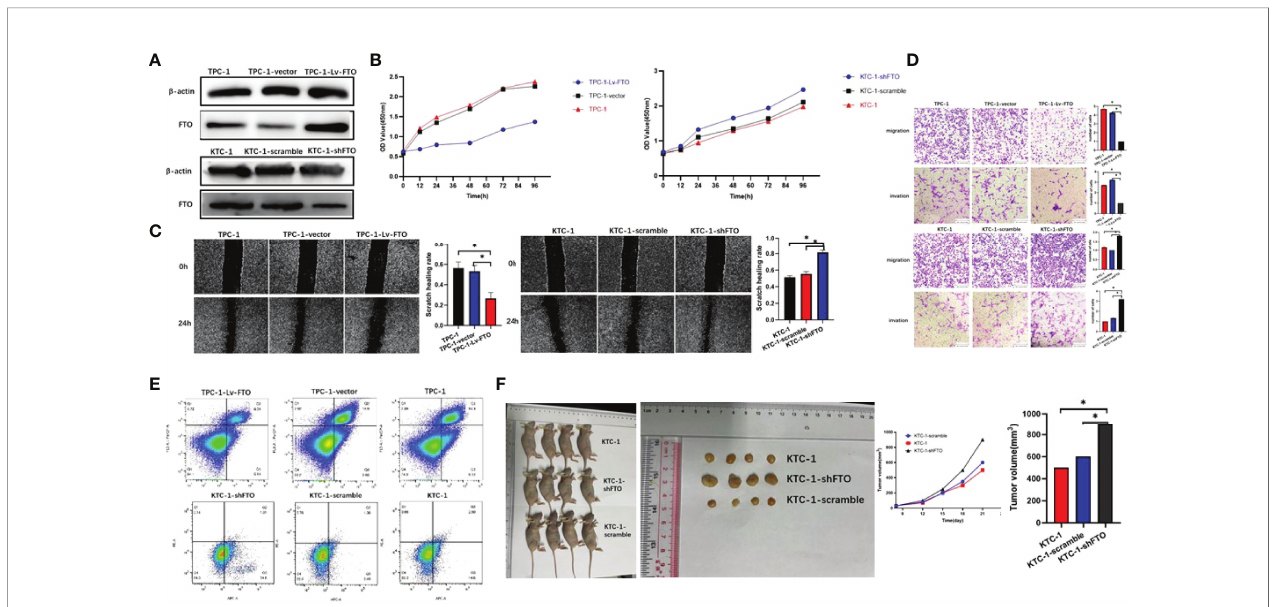
FIGURE 2 | Fat mass and obesity-associated protein (FTO) inhibits papillary thyroid carcinoma (PTC) proliferation, migration, and invasion in vitro and in vivo . (A) Construction of the FTO overexpression model of TPC-1 and the FTO silencing model of KTC-1 as veri fi ed by western blot. (B) Cell proliferation was applied to evaluate the proliferation abilities of three PTC cell lines with knockdown or overexpression of FTO. (C) Wound healing assays showed the suppressed migration of PTC cells, with knockdown or overexpression of FTO, respectively, following FTO overexpression. In contrast, FTO knockdown promoted the migration (wound closure) of PC cells. (D) Transwell migration and invasion experiment. (E) Overexpression of FTO signi fi cantly increased cell apoptosis in PTC cells by fl uorescence- activated cell sorting. (F) Macroscopic image of the tumor size in a xenograft mouse model in which the mice were injected with control and KTC-1-shFTO cells (stably knockdown FTO). The knockdown of FTO dramatically promoted PTC tumor growth in an orthotopic xenograft mouse model. *, P<0.05.